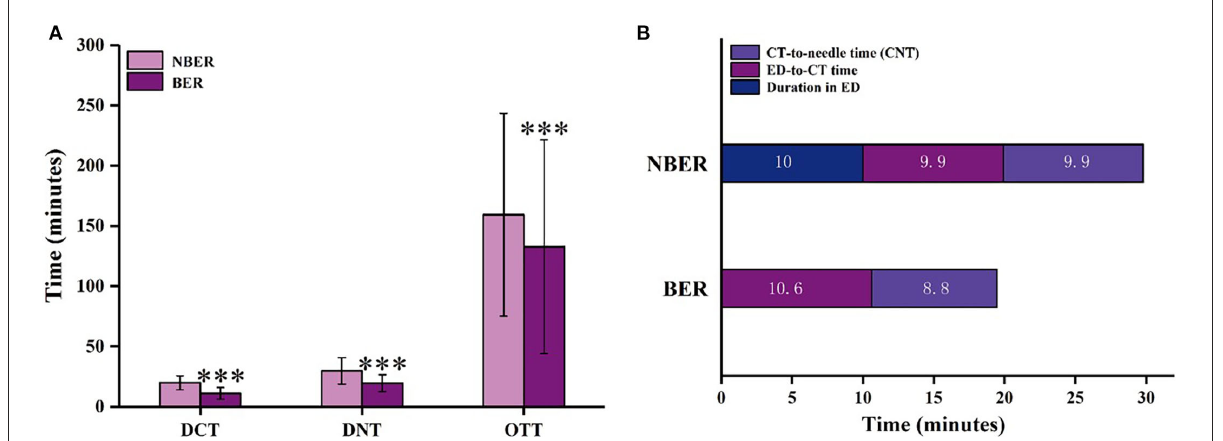
FIGURE5 The time intervals of AIS patients with intravenous thrombolysis in the NBER and BER groups. (A) DCT, DNT, and OTT of AIS patients with intravenous thrombolysis; (B) Three parts of DNT (a. Duration in ED; b. ED-to-CT time; c. CNT) in the NBER and BER groups. NBER, non-emergency bypass route; BER, emergency bypass route; DCT, door-to-CT time; DNT, door-to-needle time; OTT, onset-to-treatment time; CT, computed tomography; ED, emergency department. The data are expressed as the mean ± SD. *** p < 0.001 vs. the NBER